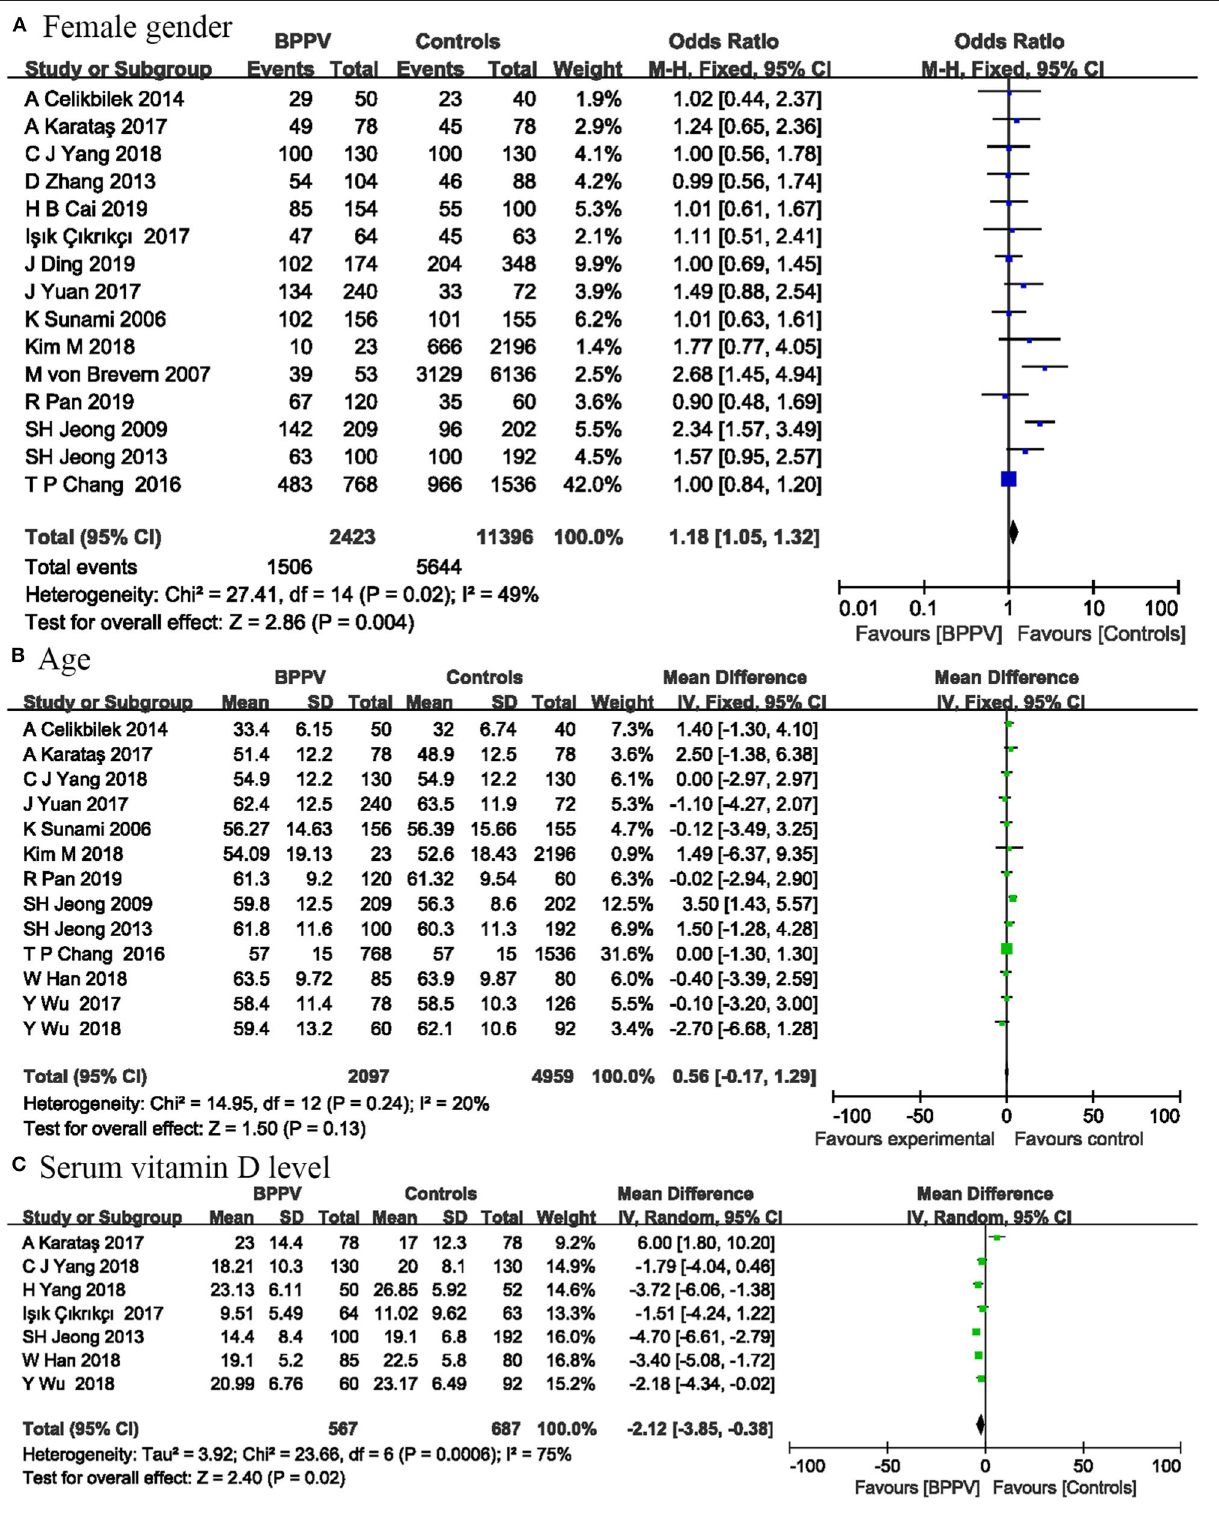
Frontiers in Neurology |